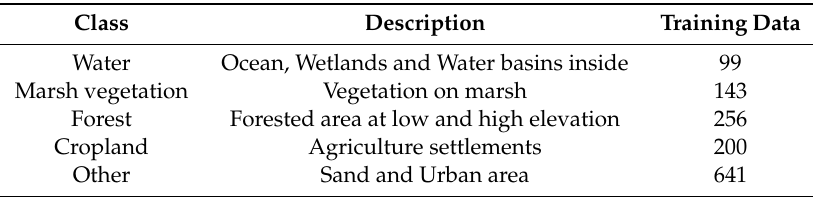
Table 1. Number of training data in each